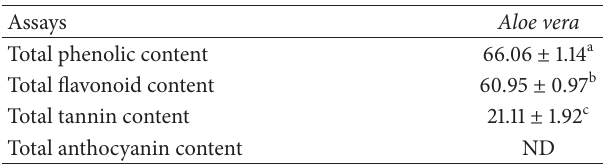
Table 6: Phytochemical content of A . vera